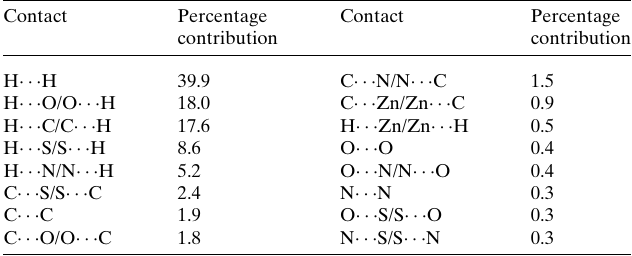
Table 4 Percentage contributions of interatomic contacts to the calculated Hirshfeld surface of (I). Contact Percentage contribution